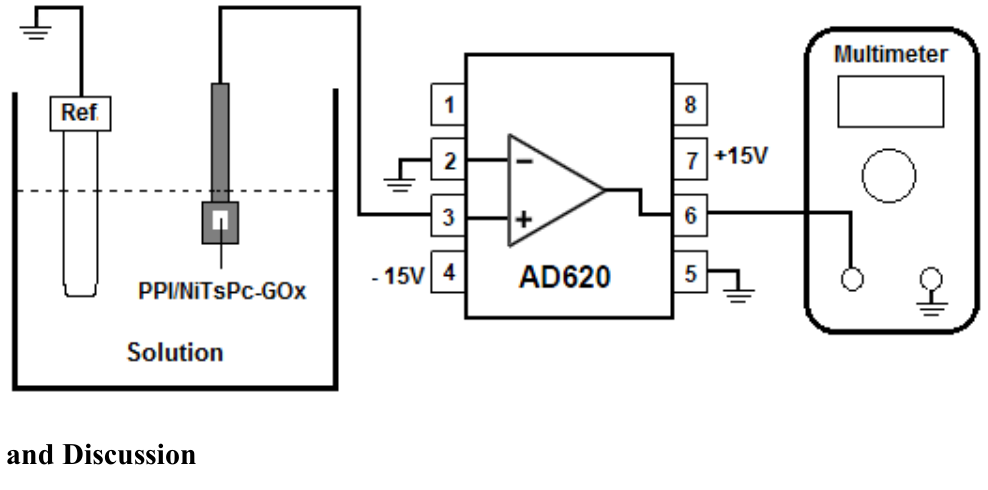
Figure 1. Schematic illustration of the FET-based biosensor measurement system showing the connection diagram of the instrumentation amplifier AD620 used as unity gain buffer.